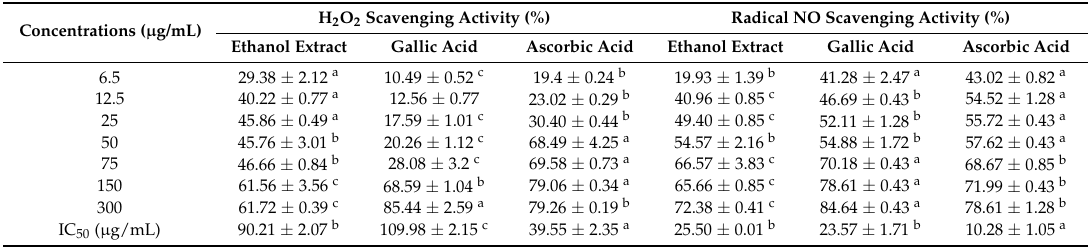
Table 1. Antioxidant activity of fruit pulp ethanol extract from Detarium microcarpum and standard